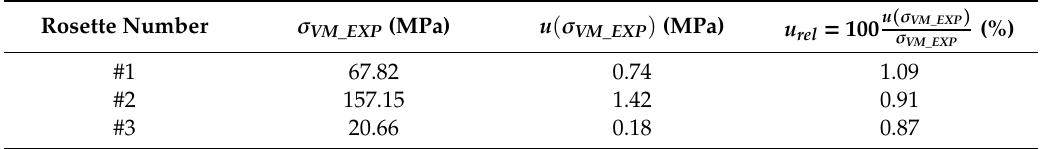
Table 7. Final experimental stress calculated from the strain gauge